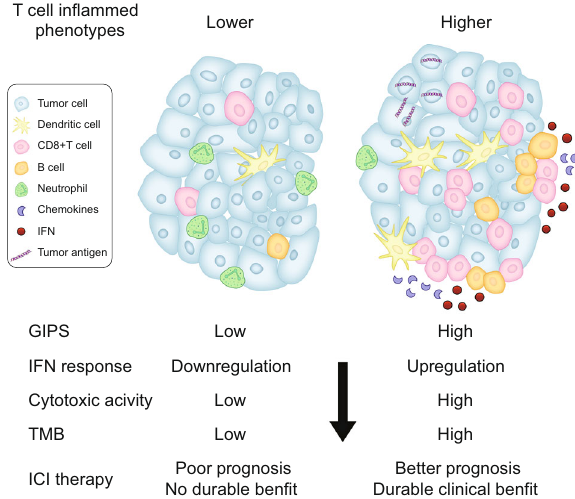
Fig. 5 Graphic abstract. The GIPS model plays a role in predicting the tumor immune phenotype and clinical outcomes of ICI treatment in gastrointestinal